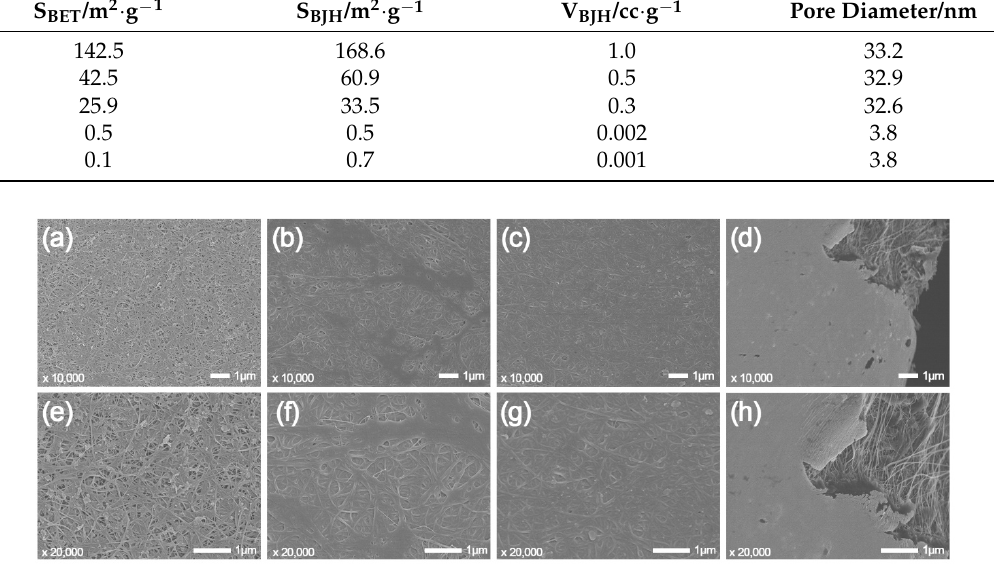
Figure 8. The surface morphology of the CNT/E51-DAD films with resin contents of ( a ) 30 wt%, ( b ) 50 wt%, ( c ) 70 wt%, ( d ) 90 wt% at 10,000 times and ( e ) 30 wt%, ( f ) 50 wt%, ( g ) 70 wt%, ( h ) 90 wt% at 20,000